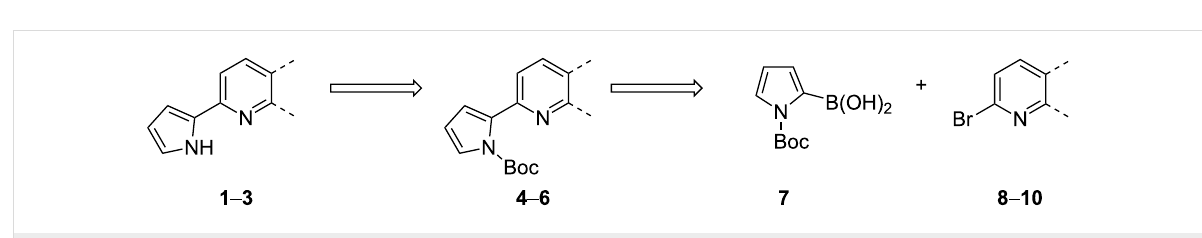
Scheme 3: Retrosynthetic approach for structures 1 – 3